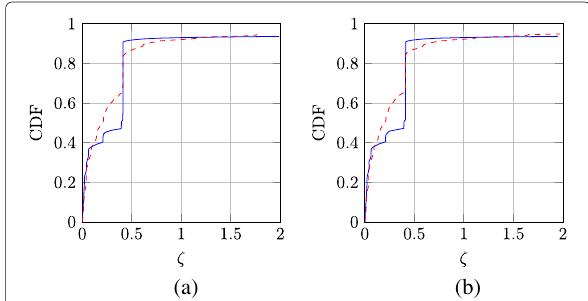
Table 3 Comparison of metrics over relative error in control, computed using Eq. 50. The error is of the form (ζ e , ζ p ) : the error of the evader and the error of the pursuer Hybrid vs optimization approach